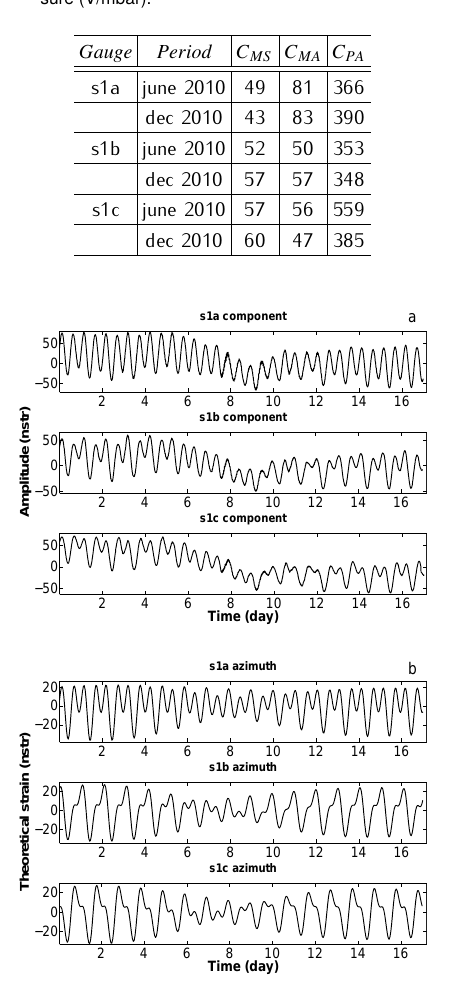
Table 1. Gauge response coefficients. ( C MS ): solid tide (V/nstr), ( C MA ): gulfwaterpressure(V/mbar),( C PA ): barometricpres- sure (V/mbar).